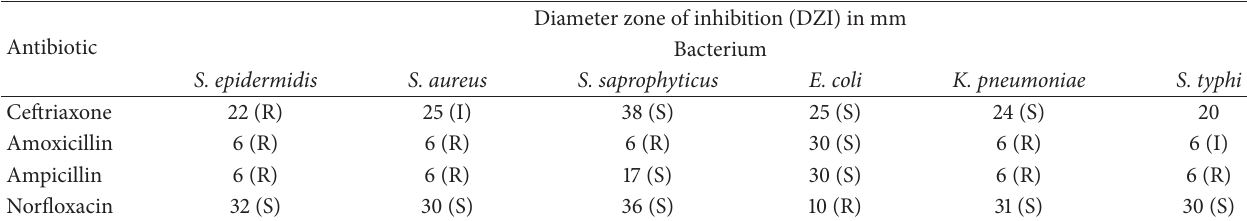
Table 6: Diameter zone of inhibition of antibiotic discs against bacteria species and resistance status. Antibiotic